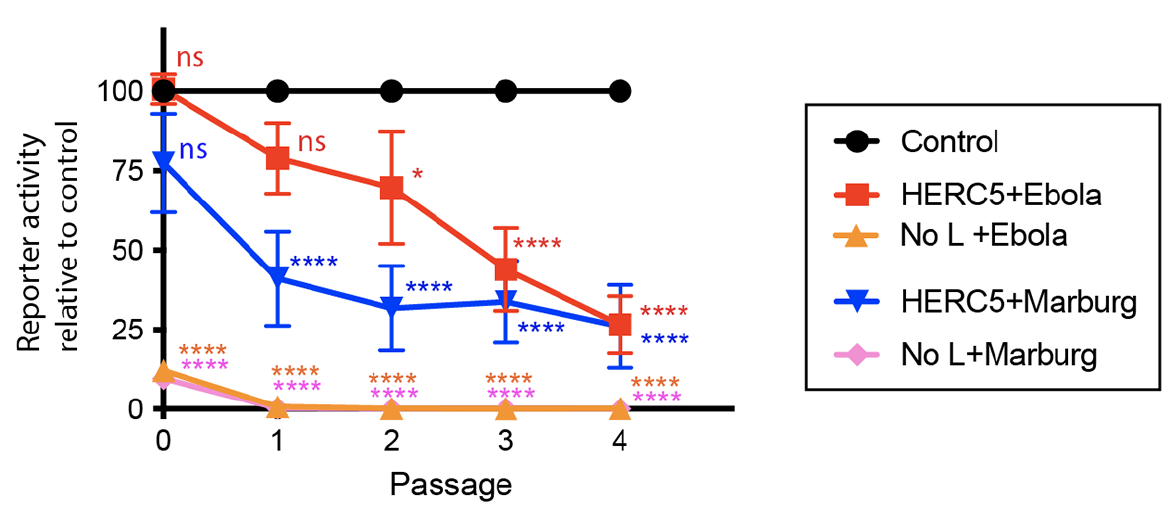
Figure 6. EBOV GP and MARV GP differentially antagonize HERC5. Quantification of trVLP propagation in the presence and absence of HERC5. The trVLP propagation assay was performed using tetracistronic minigenomes carrying a luciferase reporter, EBOV VP40, VP24 and either EBOV GP or MARV GP over four passages (spanning 12 days). All EBOV minigenomes and plasmids carrying the EBOV proteins are based on EBOV H. sapiens -tc/COD/1976/Yambuku-Mayinga. As a negative control (‘No L’), the plasmid carrying the Ebola L gene was omitted from the transfections. Luciferase reporter activity relative to the control (trVLPs propagated in the absence of HERC5) is shown. The data shown represent the average (+/− S.E.M.) of at least six independent experiments. **** p < 0.0001, * p ≤ 0.05, ns (not significant) p > 0.05; Two-way ANOVA with Dunnett’s multiple comparisons test compared to the no HERC5 control.